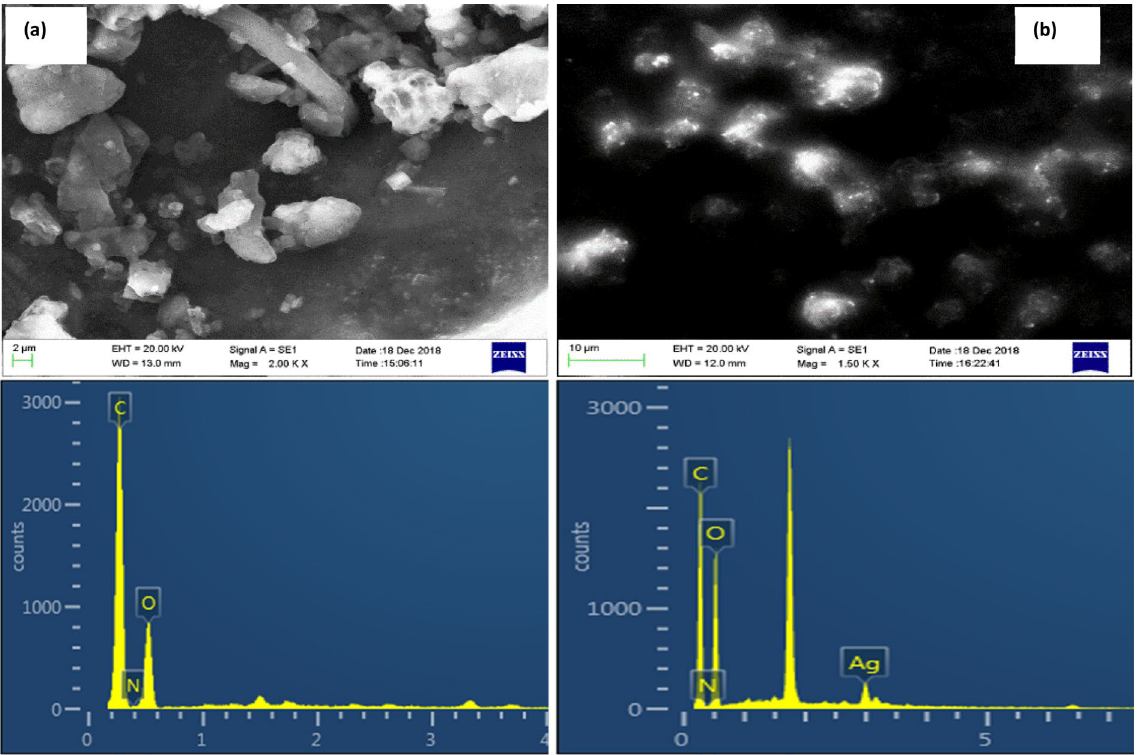
Fig. 4 Top: SEM images of morphologies and; Bottom: EDS profiles of elemental composition of dried a Et-ACPE and b Et-AgNPs as observed by